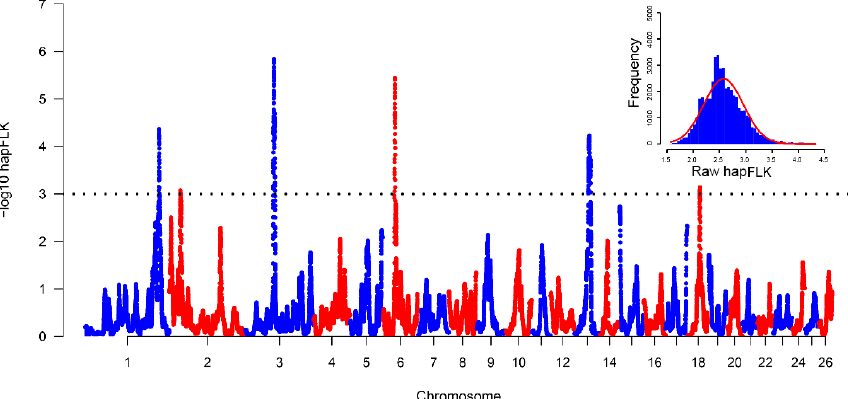
Figure 2. Manhattan plot of hapFLK statistics. The histogram in the top right shows the hapFLK statistics roughly followed a normal distribution. Black dotted line means the suggestive line; the − log P value above this line means